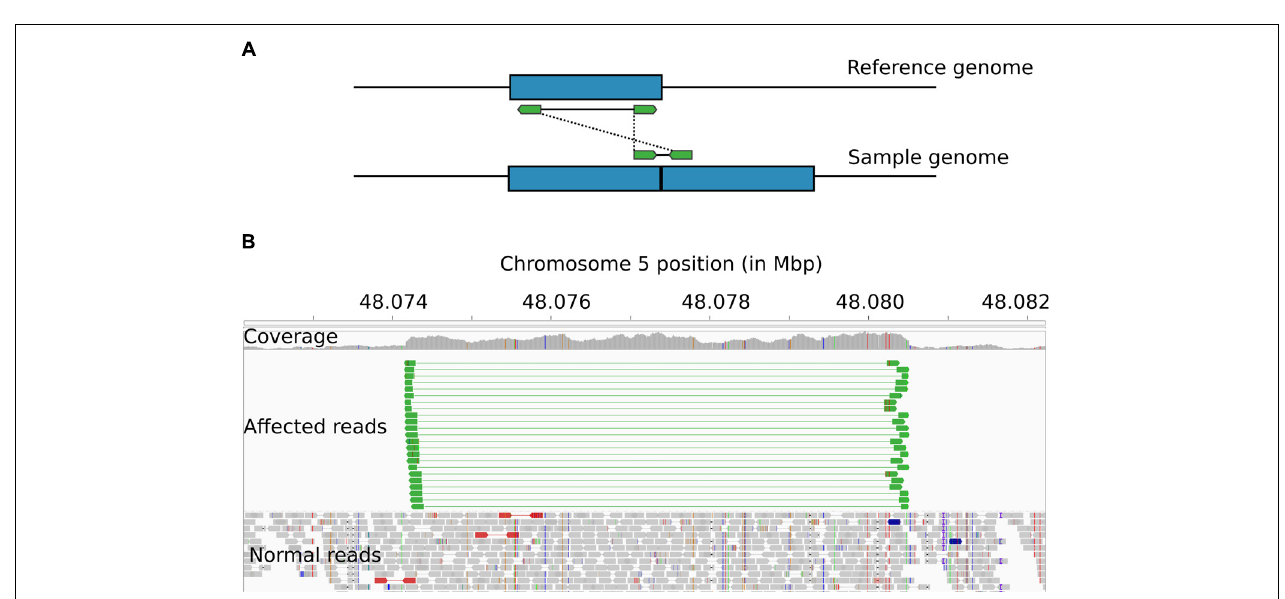
FIGURE 2 | Discovery of a B. indicus specific CNV on HMGA2 affecting navel length at yearling. (A) Relative fold increase in sequence coverage of a segment of HMGA2 intron 3 correlates with TCCTCCAAC haplotype counts in Nellore cattle. Each smoothed curve corresponds to sequence coverage averaged across samples with same haplotype count. (B) Inspection of the CNVR in additional European B. taurus and African B . indicus (marked with ∗ ) breeds reveals specificity of copy gains in B . indicus . The AC090673.2 gene annotation was manually curated and predicted from expressed sequence tags (ESTs) derived from human tissues.